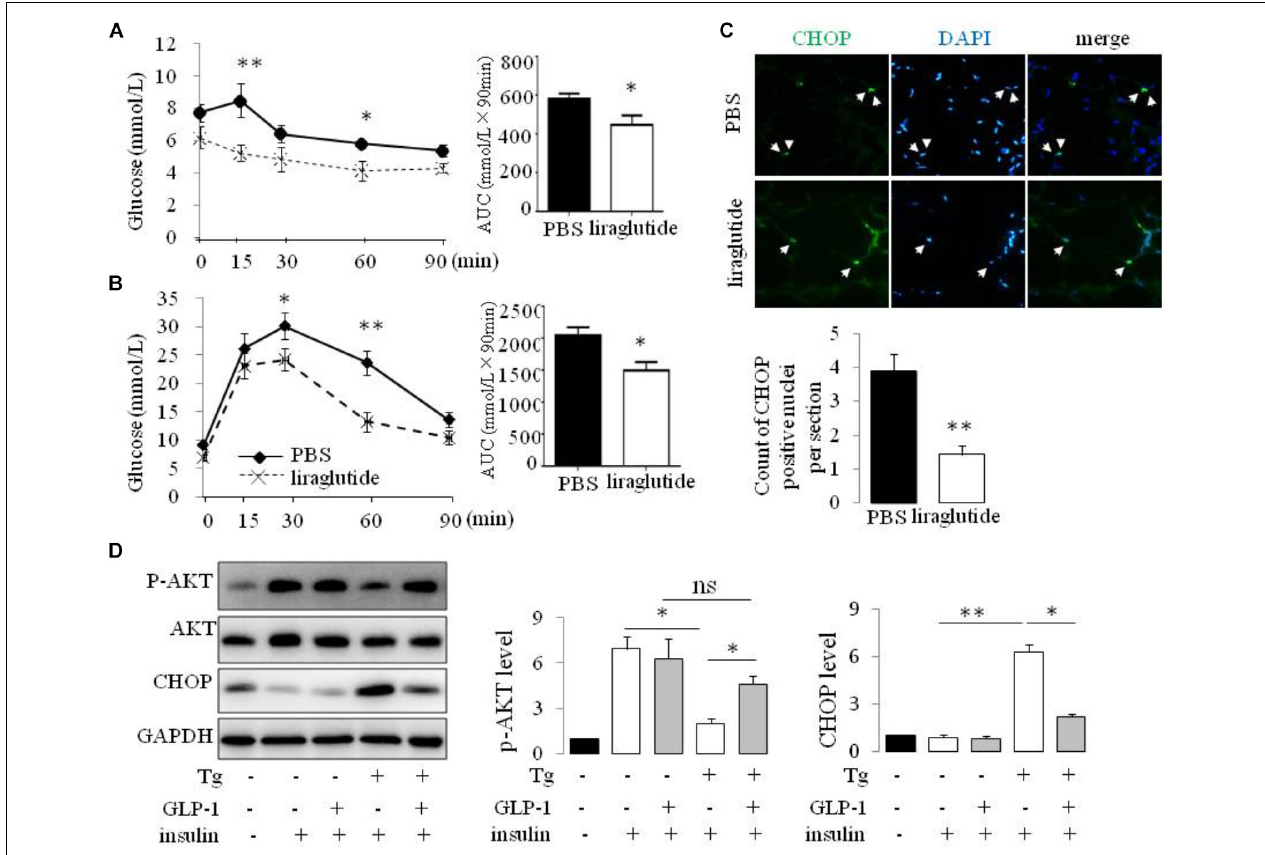
FIGURE 1 | GLP-1 reduced the expression of makers of ER stress in primary rat adipocytes subjected to ER stress and improves insulin sensitivity of ob/ob mice. ob/ob mice (6 weeks old) were given once-daily i.p. injection of PBS or liraglutide for 2 weeks. Blood glucose level in PBS- and liraglutide-treated mice were determined during IPITT (A) and IPGTT (B) . Glucose responsiveness of the corresponding experimental groups was shown as a measurement of glucose area under the curve (AUC) of the IPGTT or IPITT graph. Data represent means ± SE of 6 mice per group. (C) Photomicrographs of representative adipose CHOP staining (arrows point to CHOP-positive nuclei) in PBS- and liraglutide-treated mice. Magnification, 200 × . The numbers of CHOP-positive adipocyte were calculated in a total of 21 microscopical sections from three mice per group. Data represent means ± SE. (D) Fat pad from two rats was pooled for SVF isolation. Adipocytes differentiatied from SVF were fasted for 6 h in low-glucose DMEM media with 0.2% BSA (fasting media) and then were exposed to either vehicle alone or 5 µ M thapsigargin (Tg) in fasting media for 16 h in the absence or presence of 50 nM GLP-1. The cells were then stimulated with insulin (100 nM) in fasting media for 10 min. Two wells of cell extracts were pooled together and were analyzed by immunoblotting for phospho-AKT Ser47 (p-AKT), total AKT, CHOP, and GAPDH (loading control). Results are means ± SE of four independent experiments. ∗ P < 0.05 and ∗∗ P <